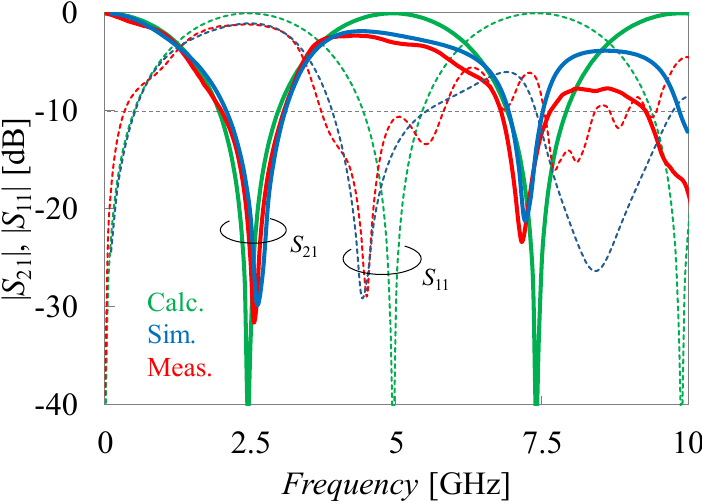
Figure 7. Compared results of | S 21 | and | S 11 | in the case of the rectangular stub when Z 1 / Z 0 = 1/2. Three kinds of data show the calculated values based on the TEM transmission line theory and the EM simulated value by using an Ansys HFSS simulator and measured values. Good agreement is obtained up to 5 GHz for the measured value and the simulated value.